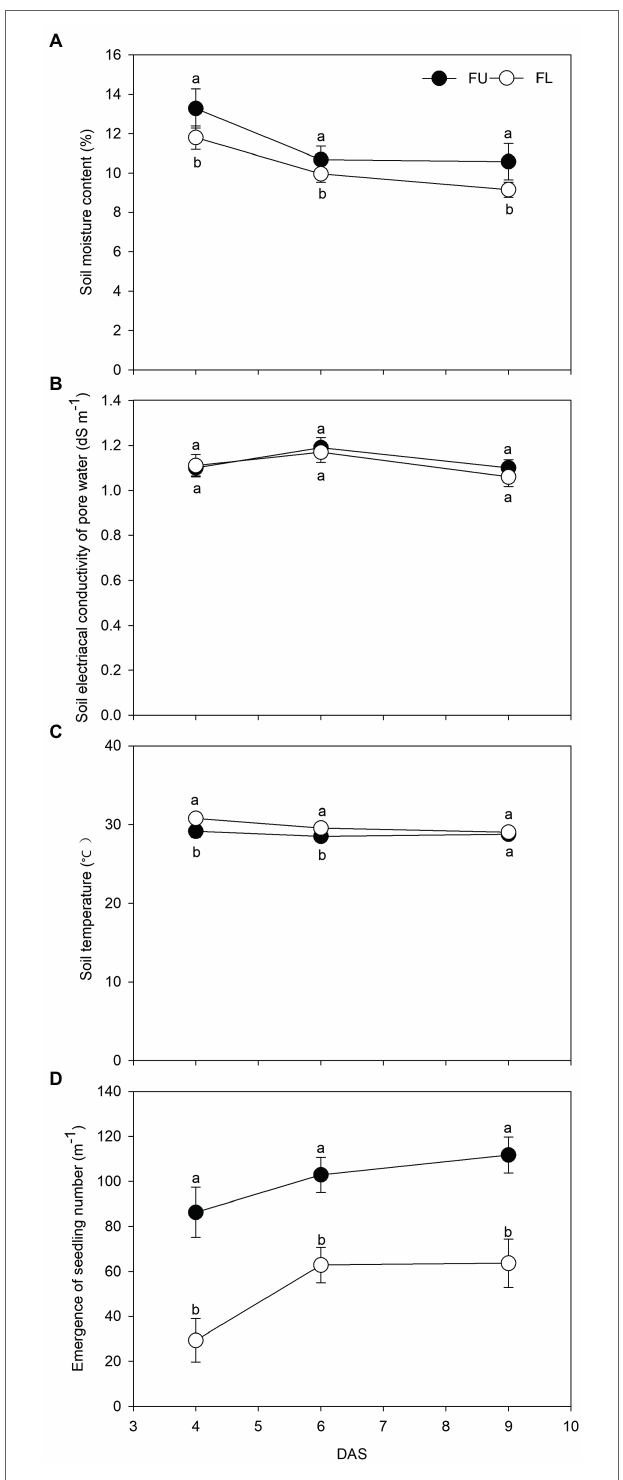
FIGURE 3 | Effects of FU and FL on Soil moisture content (A) , soil electrical conductivity of pore water (B) , soil temperature (C) , and number of emerged seedlings (D) of alfalfa 4, 6, and 9 days after sowing (DAS). During the seedling stage. Solid circles show FU treatment; hollow circles show FL treatment. Values are means ( n = 4) ± SE. Same lowercase capital letters indicate no significant difference between two seeding patterns at p ≤